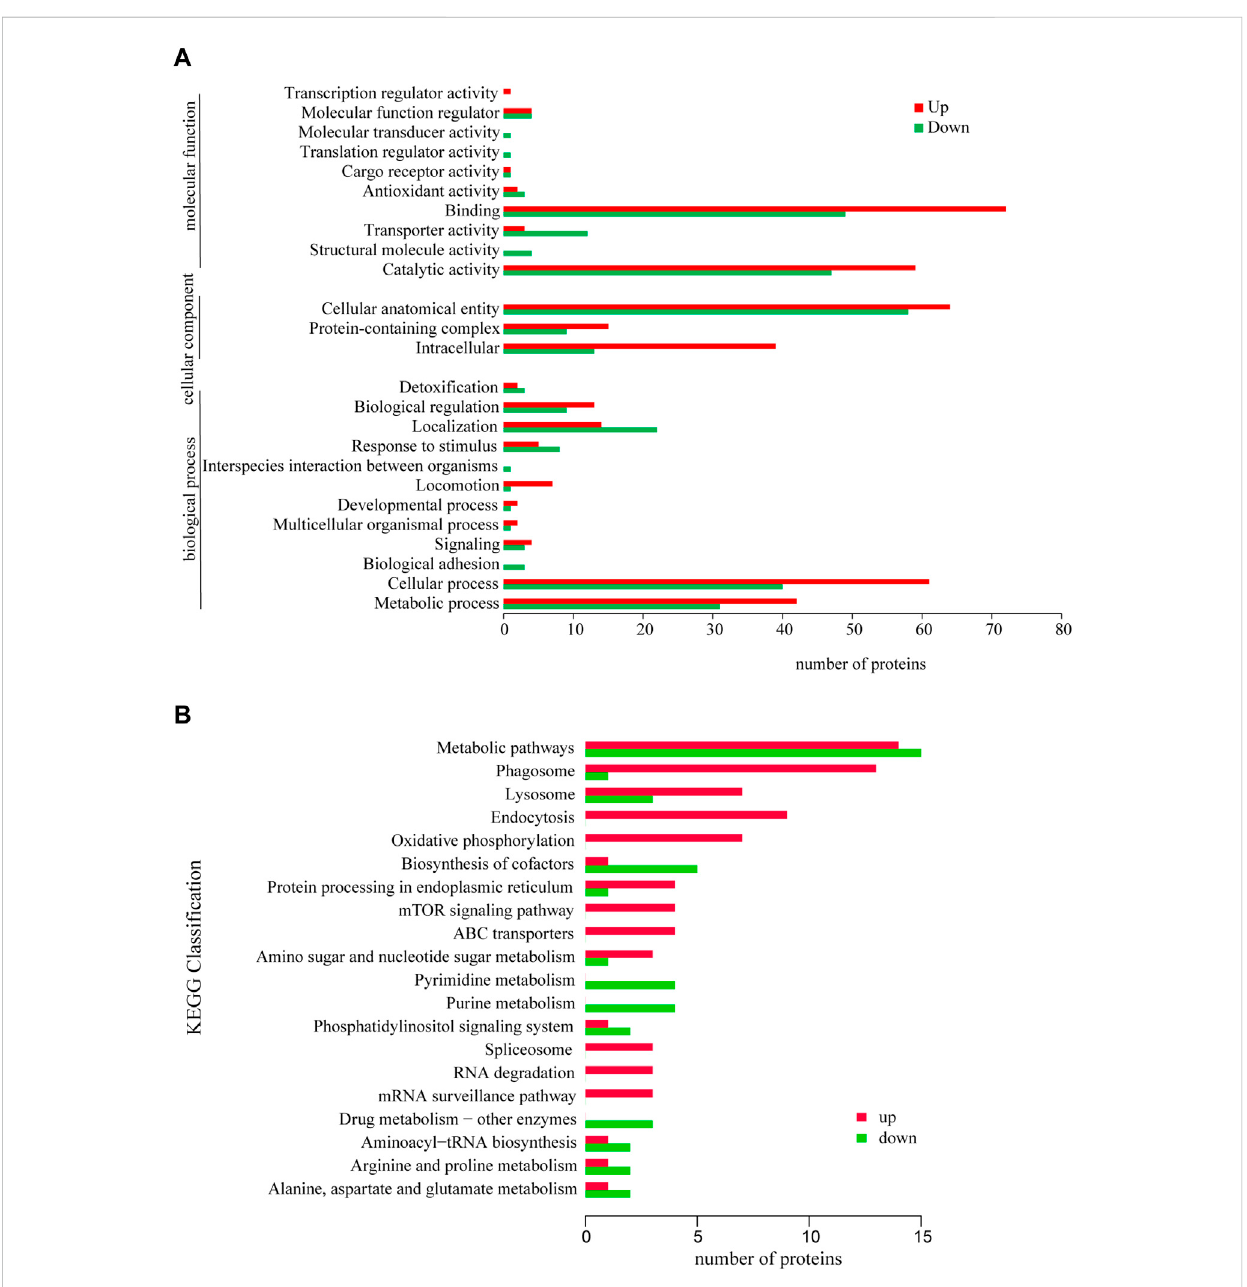
FIGURE 3 GO annotation analysis of differentially expressed proteins (A) and KEGG annotation analysis of differentially expressed proteins (B) . * p < 0.05 or ** p < 0.01 versus starvation group.